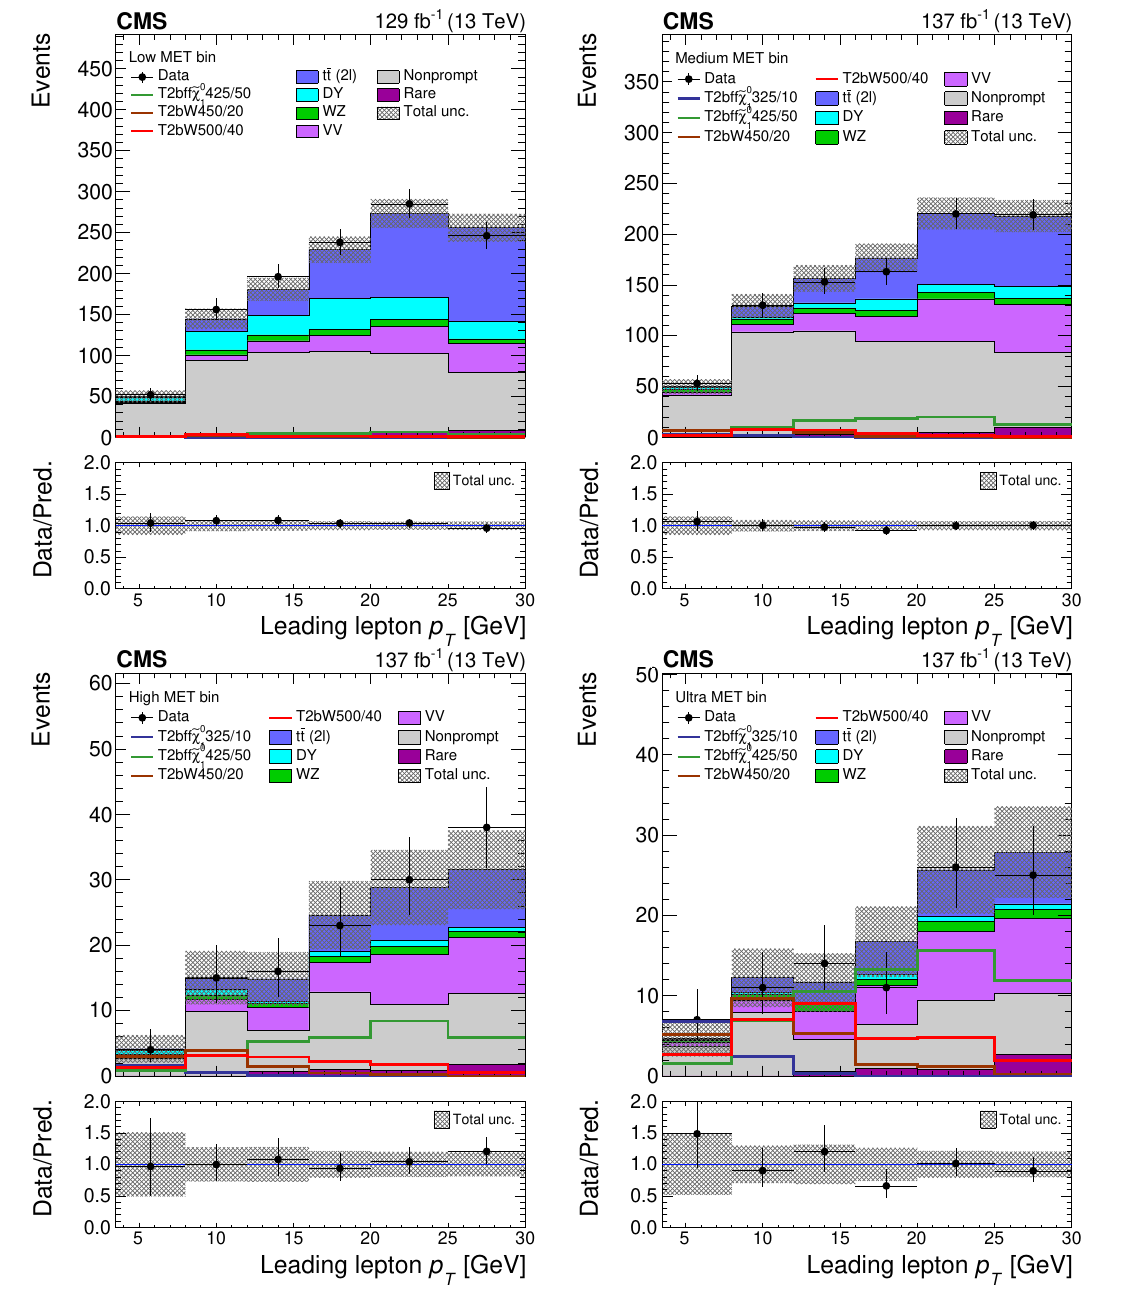
variable is shown for Figure 7 . The 2 ‘ -Stop SR: the post-fit distribution of the leading lepton p T the low- (upper left), medium- (upper right), high- (lower left) and ultra- (lower right) MET bins. Uncertainties include both the statistical and systematic components. The signal distributions 0 overlaid on the plot are from the T2b ff and the T2bW models. The numbers after the model e c 1 name in the legend indicate the mass of the top squark and the mass splitting between the top squark and LSP, in